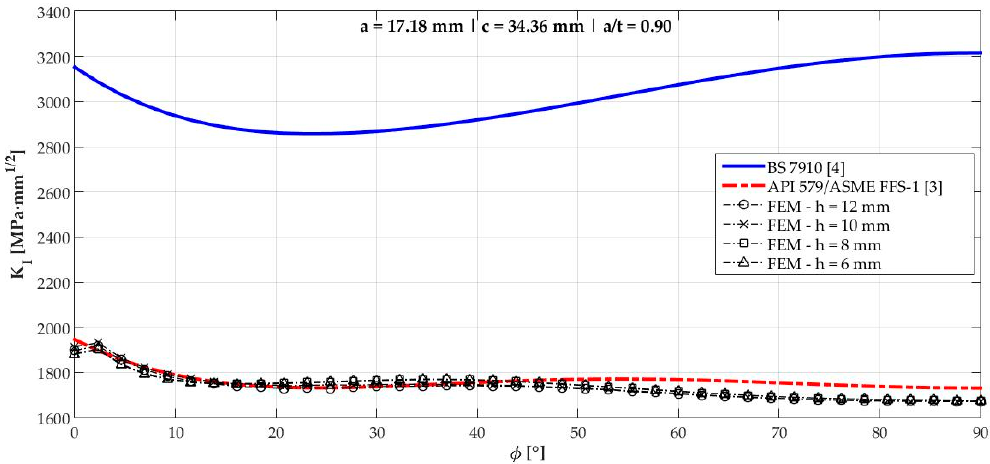
Figure 15. Mode I SIF profiles for crack 10 ( a = 17.18 mm , c = 34.36 mm , and a/t = 0.90 ).